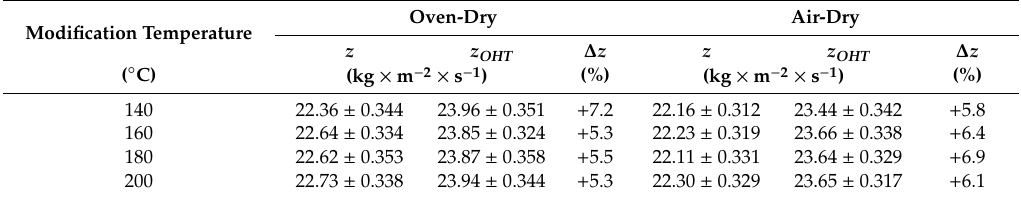
Table 3. Mean value of spruce wood acoustic impedance, before and after modifications, at di ff erent temperatures and moisture content; ± (SD).